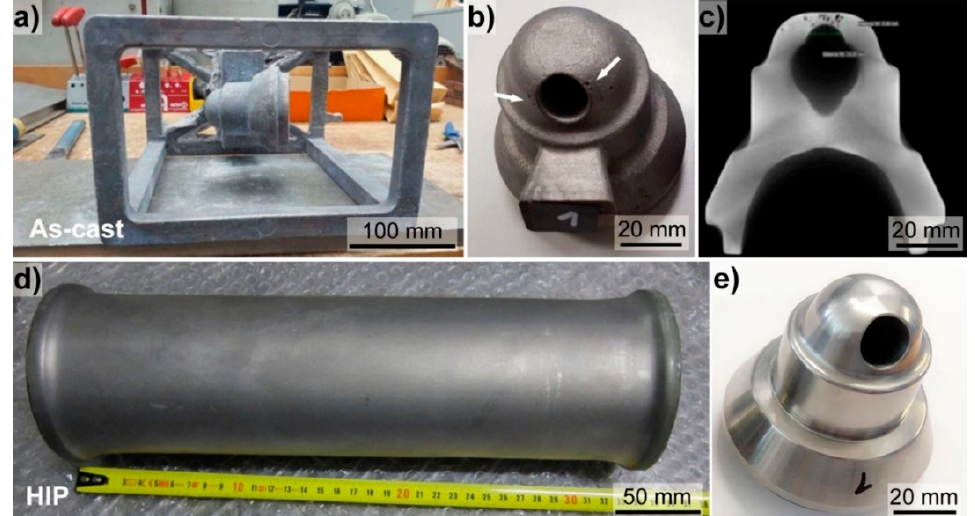
Figure 6. Overview on manufacturing of prechamber prototypes made of the Fe-Al-Mo-Ti-B alloy via ( a – c ) investment casting, and ( d , e ) HIP. (a) Complete as-cast part after removing the ceramic shell, ( b ) as-cast prechamber revealing some open pores (indicated by white arrows), a smooth surfaces was apparent and the shape of the prechamber was well replicated; ( c ) computer tomography (CT)-scan of the as-cast prechamber; ( d ) stainless steel capsule after HIP, ( e ) final machined prechamber made from the HIP-bar.